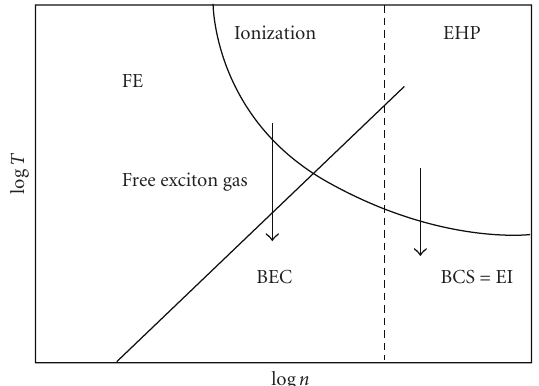
Figure 2: General structure of the phase diagram of an electron- hole system. FE: free excitons; EHP: electron-hole plasma; BEC: Bose-Einstein condensate of excitons; EI: exciton insulator state, which is a BCS-like state with a Fermi level for the electrons and for the holes. The transition from BEC to BCS may be gradual. At high pair density n , decreasing the temperature gives one critical T c in which both pairing and condensation occur, in the EI (BCS-like) state. At lower density, there can be two critical temperatures: one for pairing and a second for